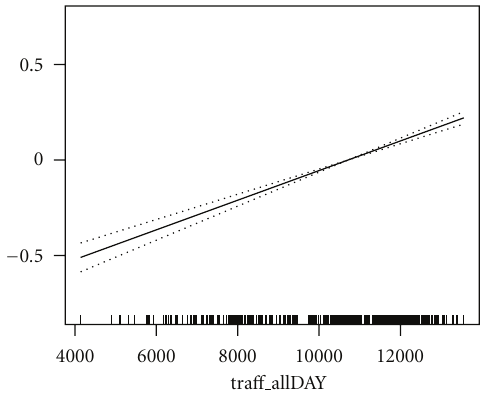
Figure 8: Estimated e ff ects of tra ffi c for PM 10 (model M 2 ). Table 4: Estimated coe ffi cients and standard errors of the para- metric part of the additive predictors for PM 10 (bold indicates 5%